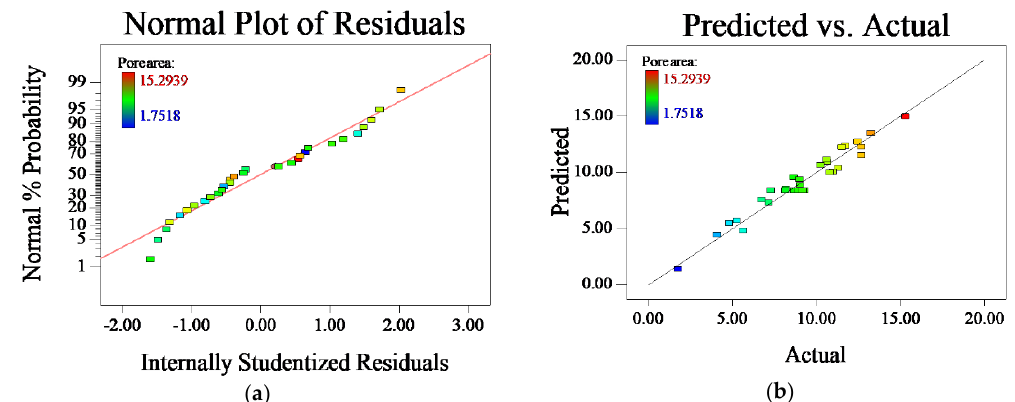
Figure 4 . ( a ) Residual analysis of pore area; ( b ) Comparison plot between predicted and actual pore area